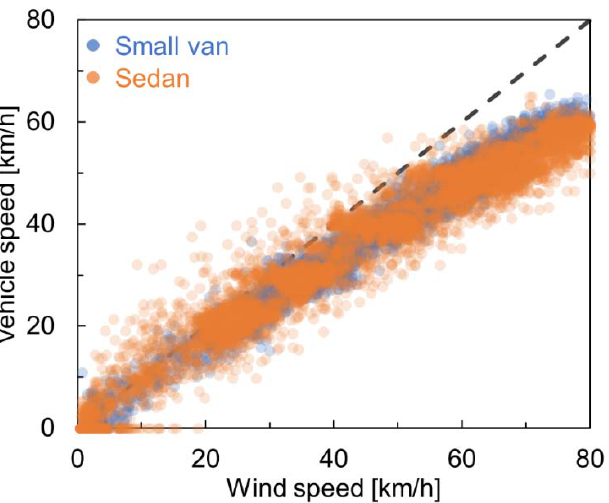
Figure 6. Relationship between vehicle speed and wind speed: small van (blue), sedan (orange). The vehicle speed was calculated from GPS data. Wind speed was measured using an anemometer, as shown in Figure 2.